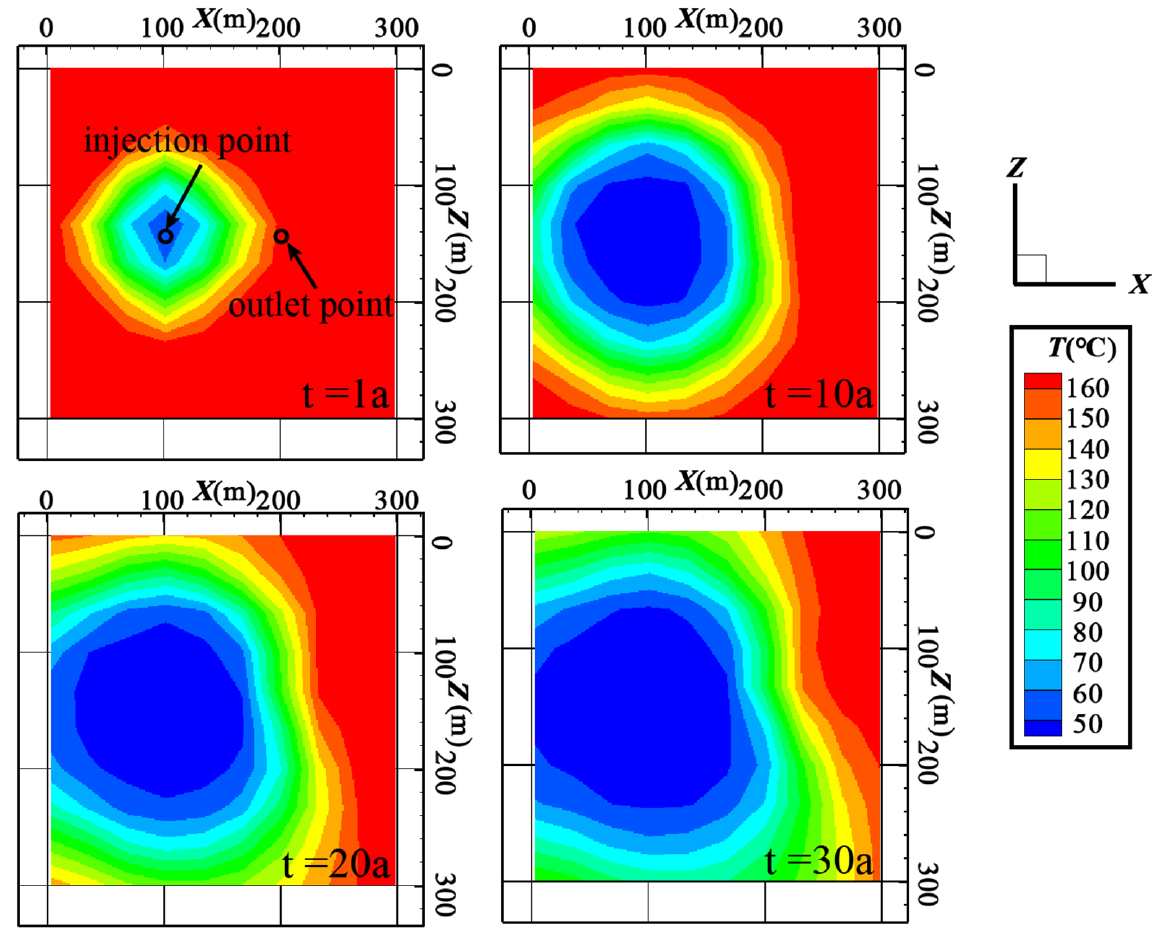
Figure 15. Temperature distribution for the conventional double vertical wells.